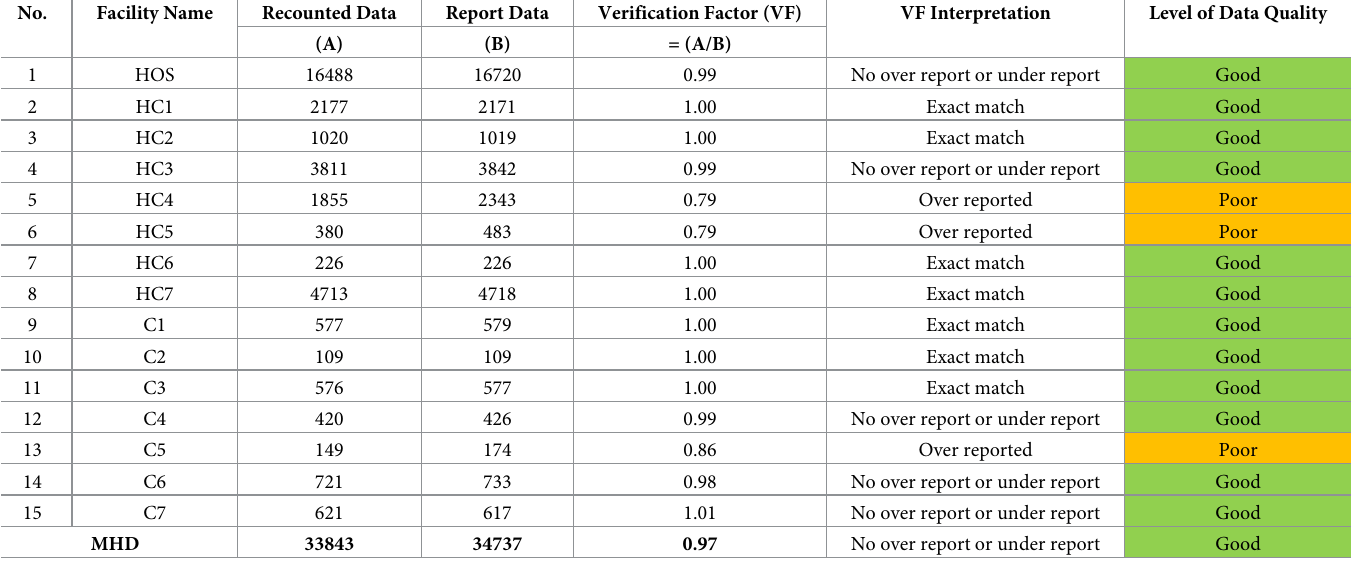
Table 4. Accuracy of reported number of suspected malaria cases: Verification